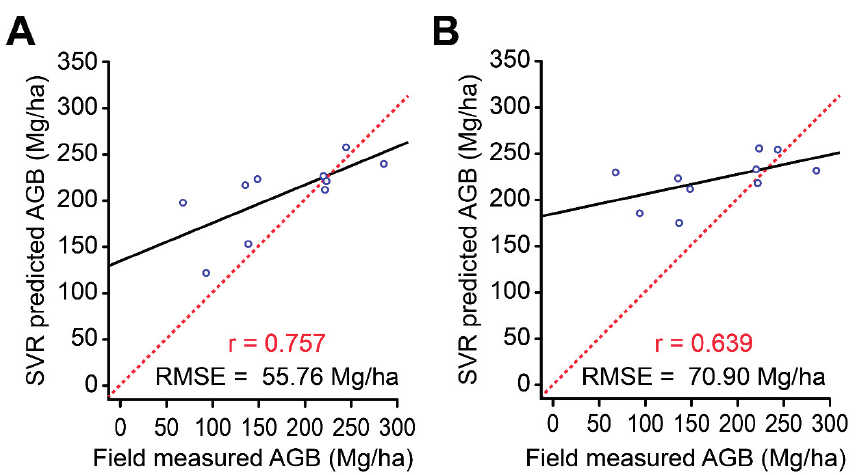
Figure 4. Support vector regression (SVR)-predicted AGB vs. field-measured AGB, as derived from VHR imagery via the grey level co-occurrence metric (GLCM) method using ( A ) horizontal canopy variables (HCV) + vertical canopy height (VCH) and ( B ) HCV only. Solid black lines represent regression lines; red dashed lines represent 1:1 correspondence